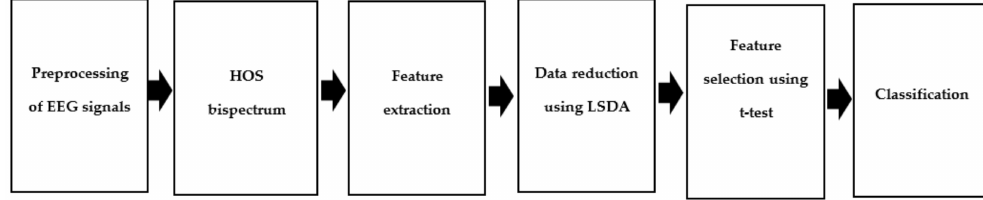
Figure 1. Workflow of our recommended method; * HOS: higher-order spectra; LSDA: locality sensitivity discriminant